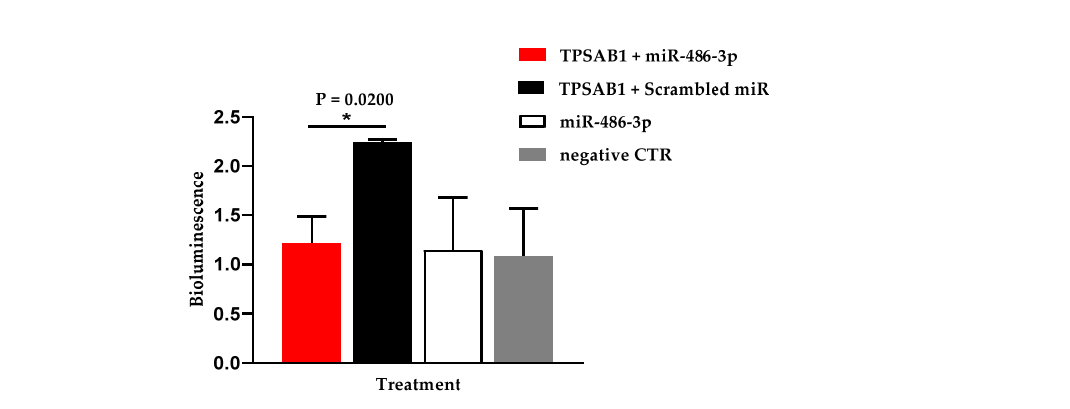
Figure 5. Luciferase bioluminescence after transfection of H9C2 cells with hsa-miR-486-3p and hsa-TPSAB1. Bioluminescence was recorded 24 h after transfecting H9C2 cells with 0.25 µg of hsa-TPSAB1 3 ′ -untranslated region-containing plasmid and 1.25 µL has-miR-486-3p or scrambled miRNA. Two control groups did not include the luciferase reporter gene, and cells were transfected with only hsa-miR-486-3 or remained untransfected (i.e., contained an equivalent volume of culture medium to replace the miRNAs or hsa-TPSAB1). Data are shown as mean ± SEM shown ( n = 3 batches of experiments; * p ≤ 0.05).